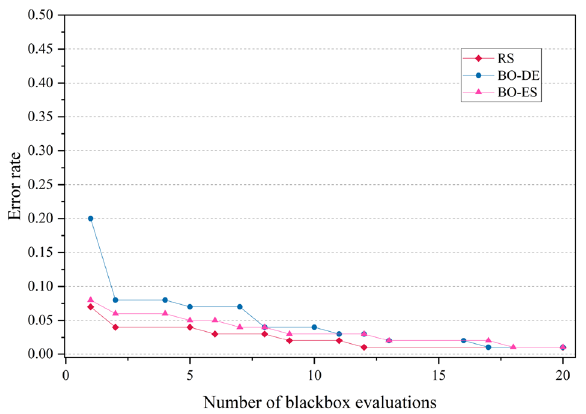
Figure 9. Comparison of the error rates of AlexNet against the number of function evaluations for BO-ES, BO-ES, and RS using MNIST data.